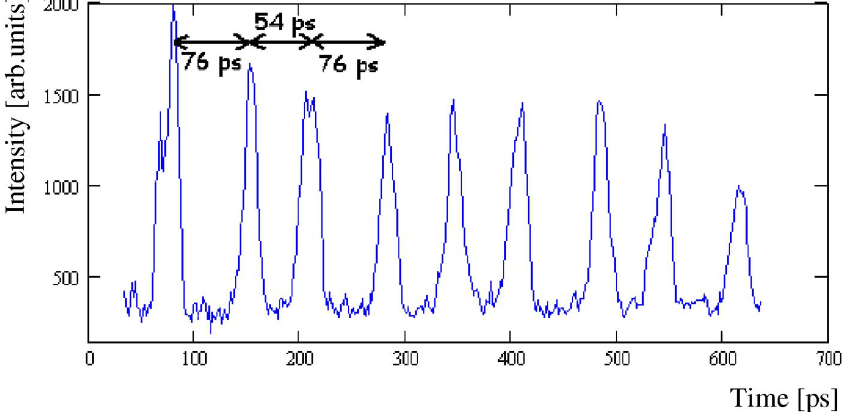
FIG. 24. (Color) Longitudinal intensity profile for bunch train combination of factor 5 showing bunch spacing variations. Here, the correct bunch spacing should be 333 = 5 ’ 67 ps